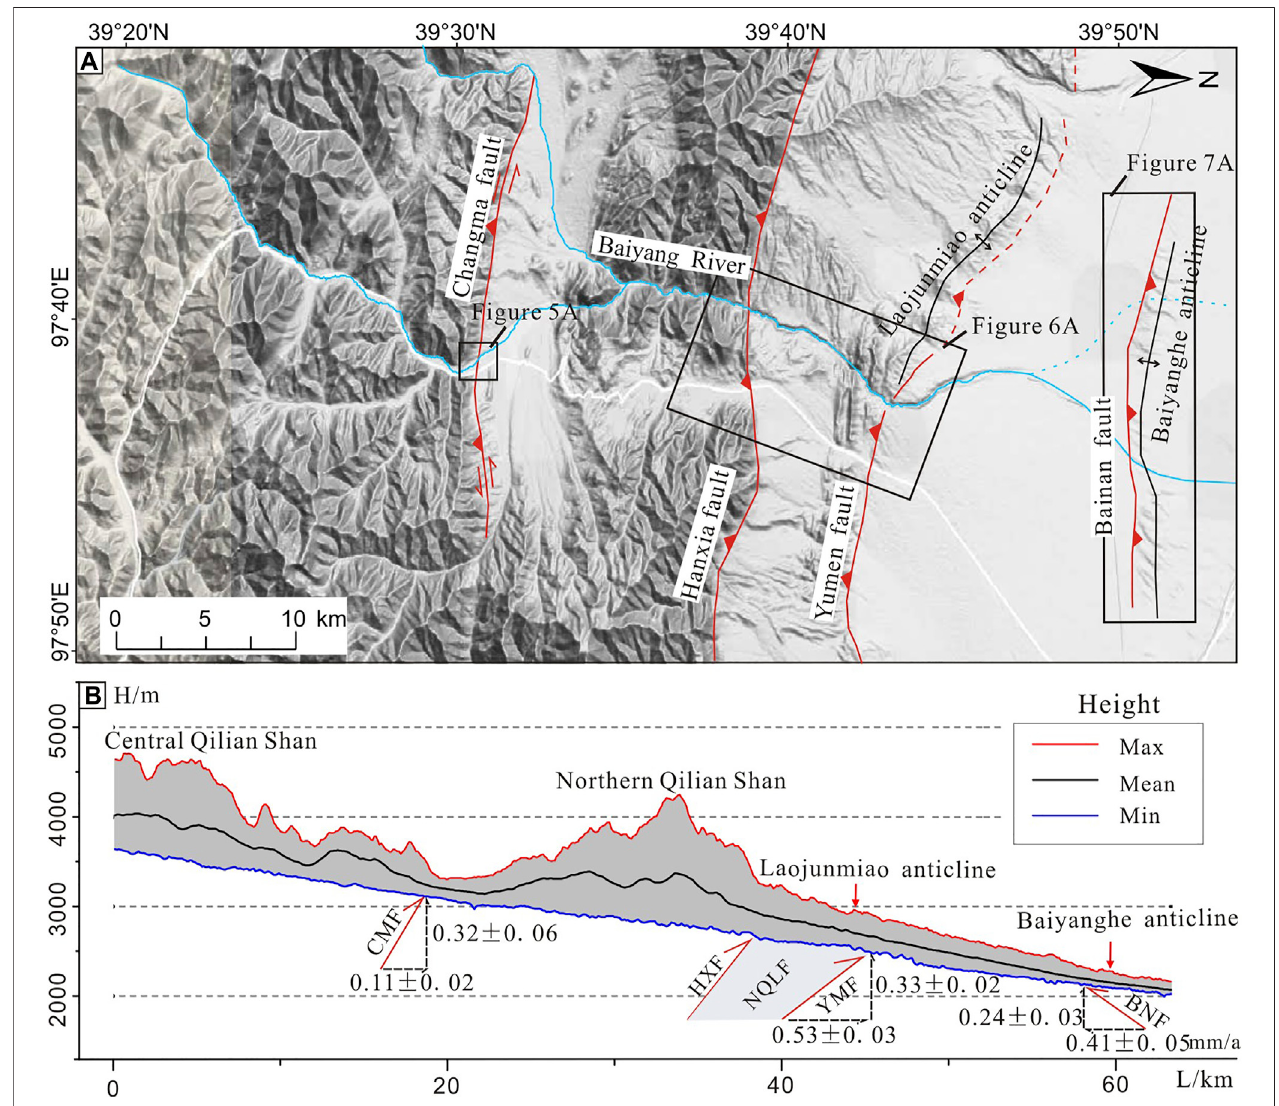
FIGURE8|(A) Thetopographicmap oftheBaiyangrivercatchment.The rangeofthemap isshown inthe whiteframein Figure 2 . (B) Thetopographicpro fi lesof the Baiyang river showing the uplift and shorteningslip ratesof active faults. Max, Mean, and Min curves representthe maximum,average, and minimum ofelevations in the Baiyang river catchment, respectively. Abbreviations of fault names: CMF, Changma fault; HXF, Hanxia fault; NQLF, Northern Qilian fault; YMF, Yumen fault; BNF, Bainan fault (Liu et al., 2017a; revised).